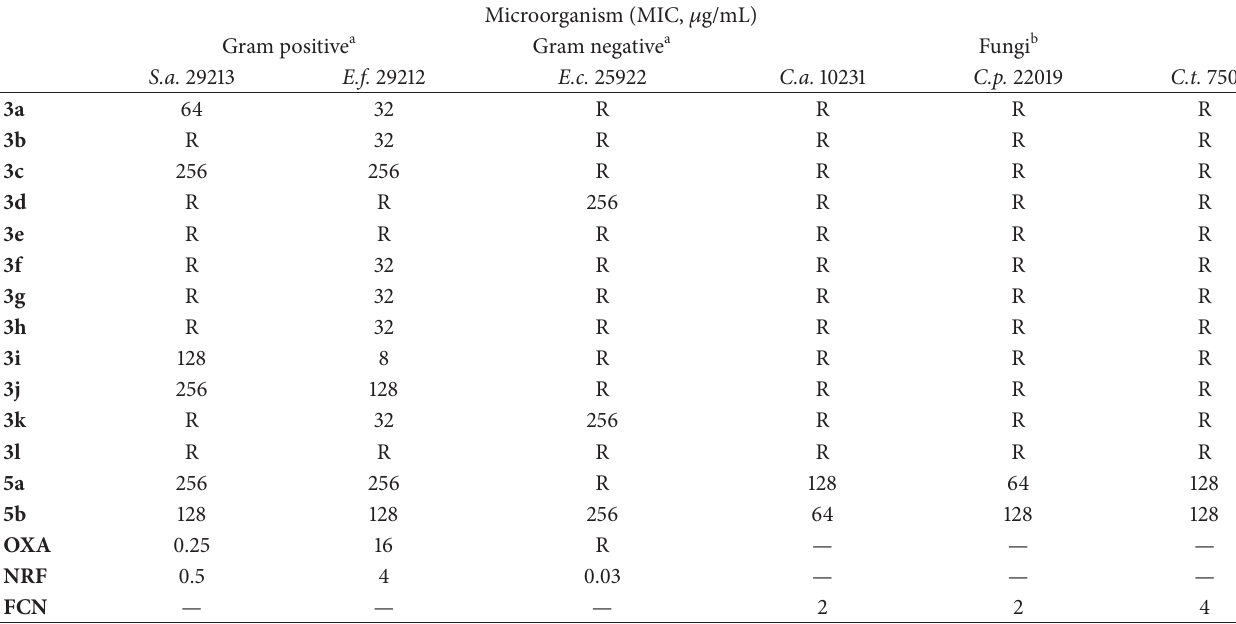
Table 2: Antimicrobial activity results of benzothiazole derivatives 3a-l and 5a,b (MIC, 𝜇